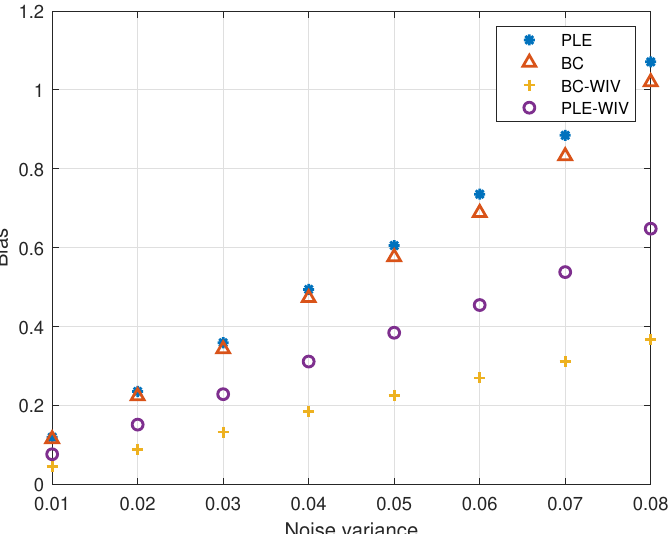
Figure 6. Bias norm MSE with increasing noise standard deviation with the variance difference of 0.01 radian 2 for each